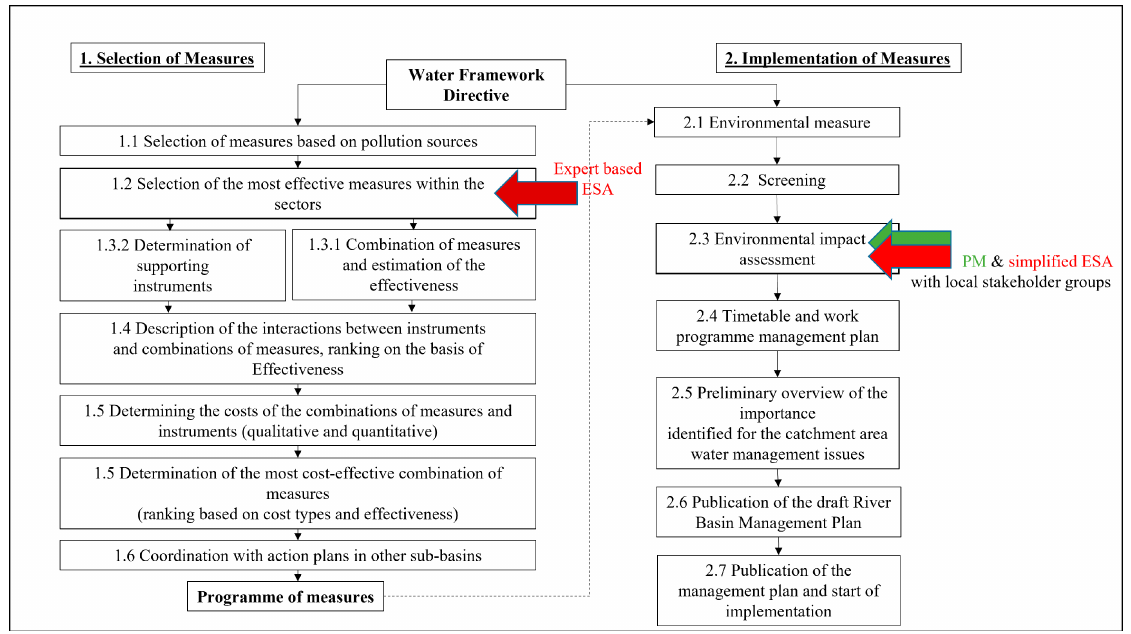
Figure 5. Flow chart of the planning and implementation process of the WFD in Germany and indication where ESA and a combination of PA and ESA could be beneficial to accelerating the selection and implementation of new mitigation measures.